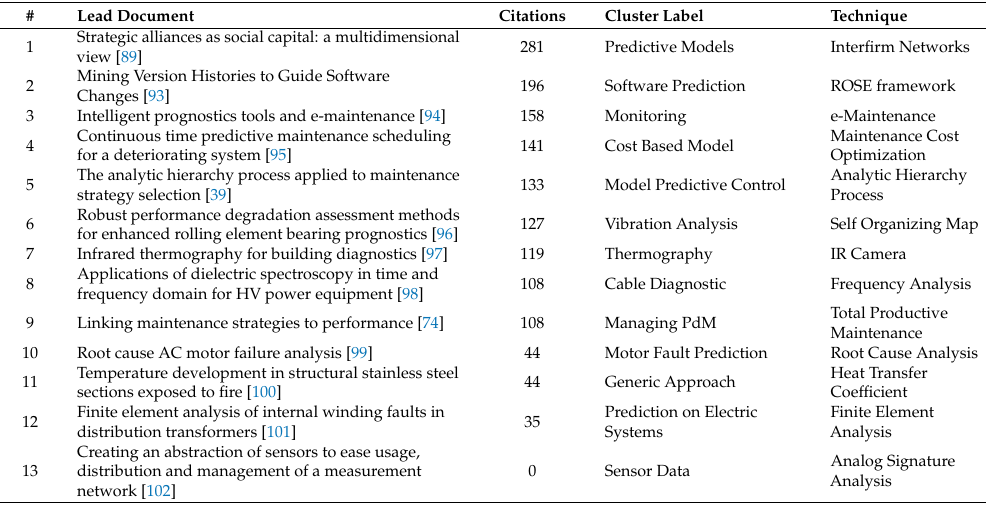
Table A1. Research field and technique of the most cited papers